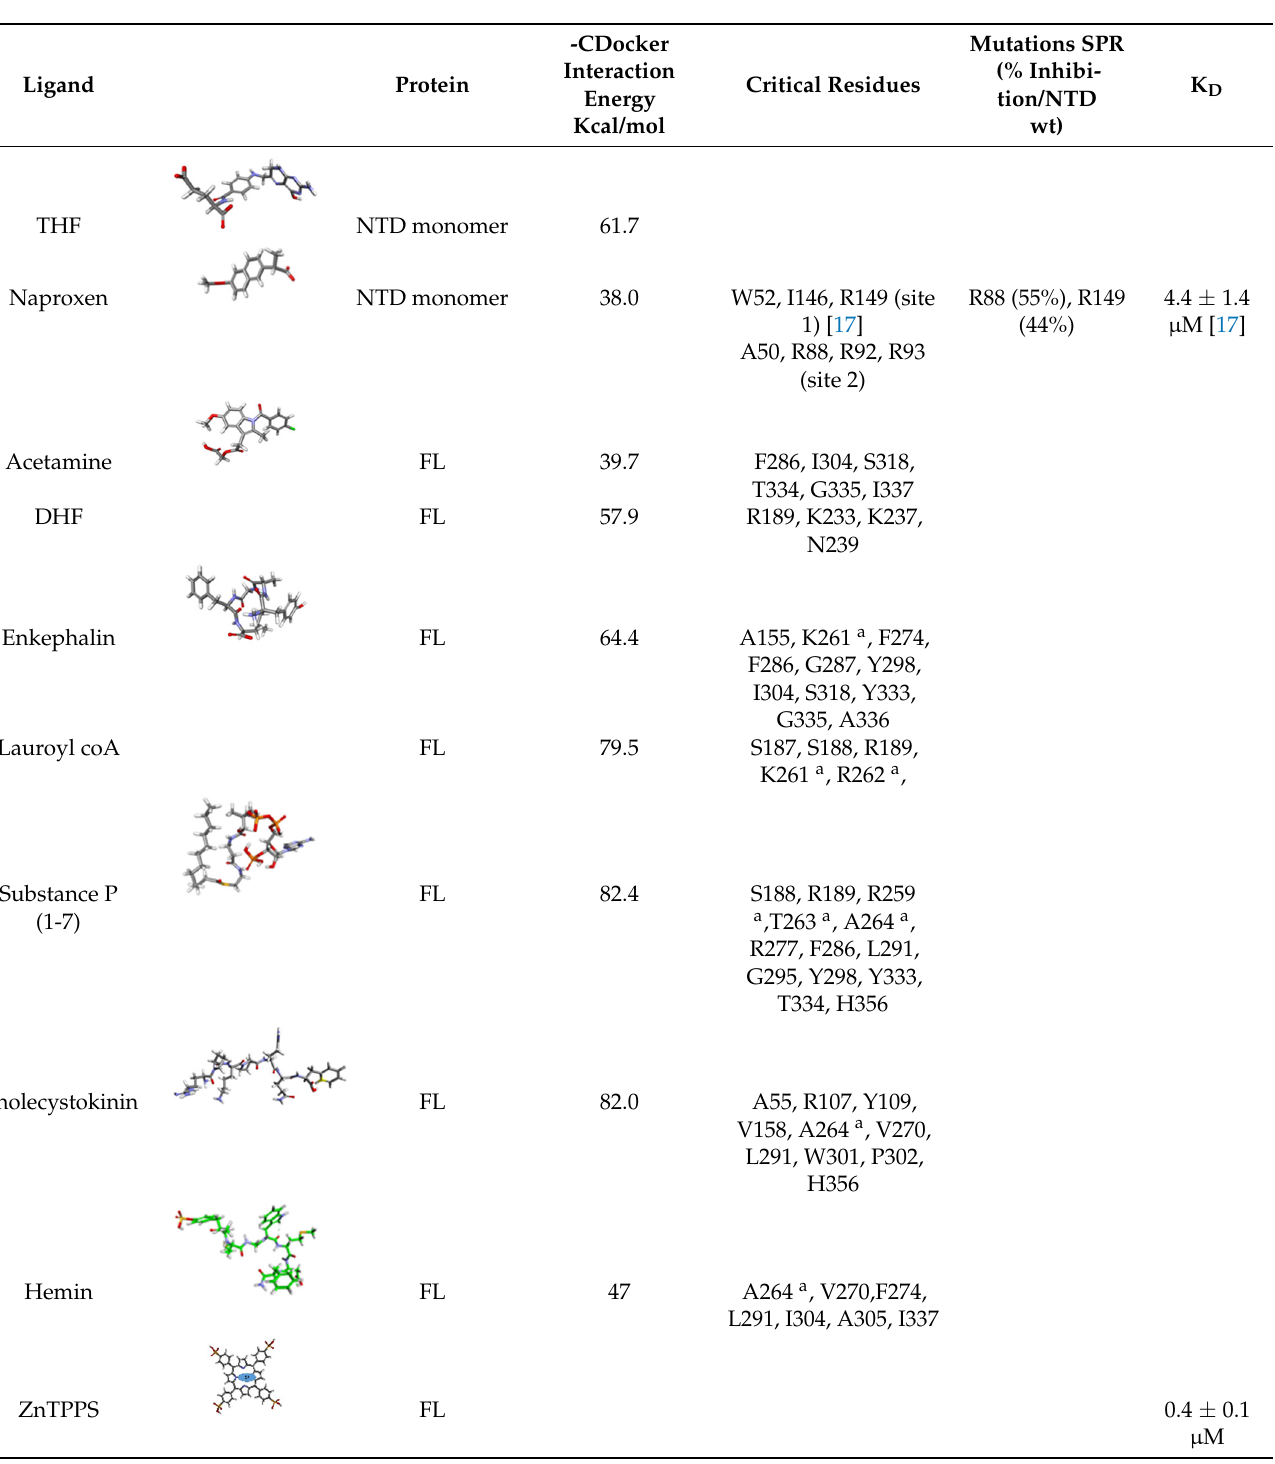
Table 2 . Summary of the ligand-N interactions obtained by modeling compared to the measured complex by surface plasmon resonance with wt or mutant NTD or wt FL .